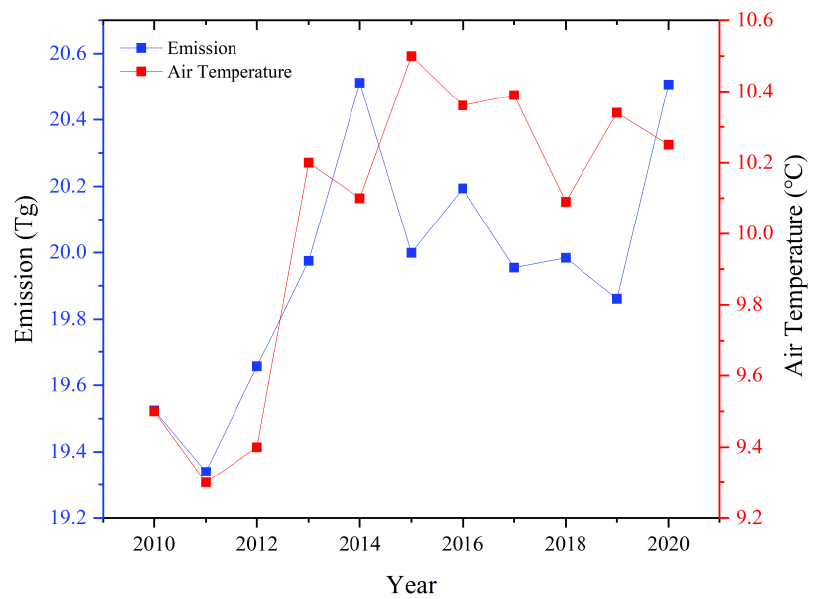
Figure 7. Annual methane emission from terrestrial ecosystem and average Air Temperature in China. (China’s average Air Temperature data come from China Climate Bulletin from 2010 – 2020).